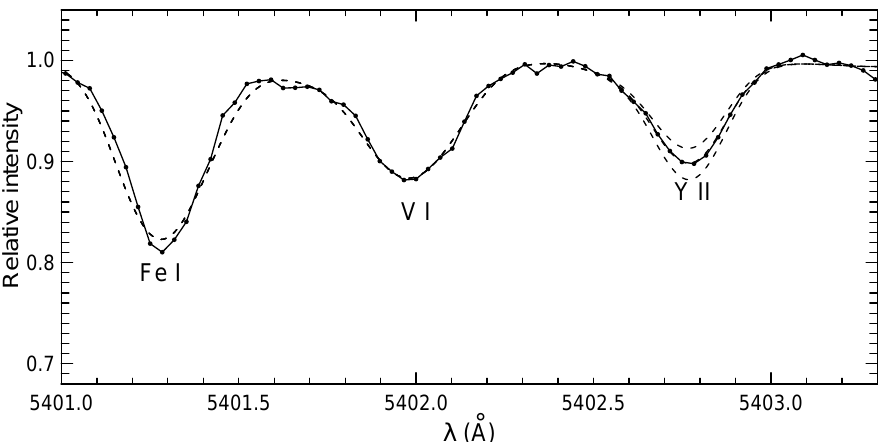
Fig. 5. Synthetic spectrum fit to the Y ii line at 5402.78 ˚A for (cid:21) And. The observed spectrum is shown as the solid line joining the dots. The dashed lines denote the synthetic spectra with [Y/Fe] = 0.05, 0.15 and 0.25 dex